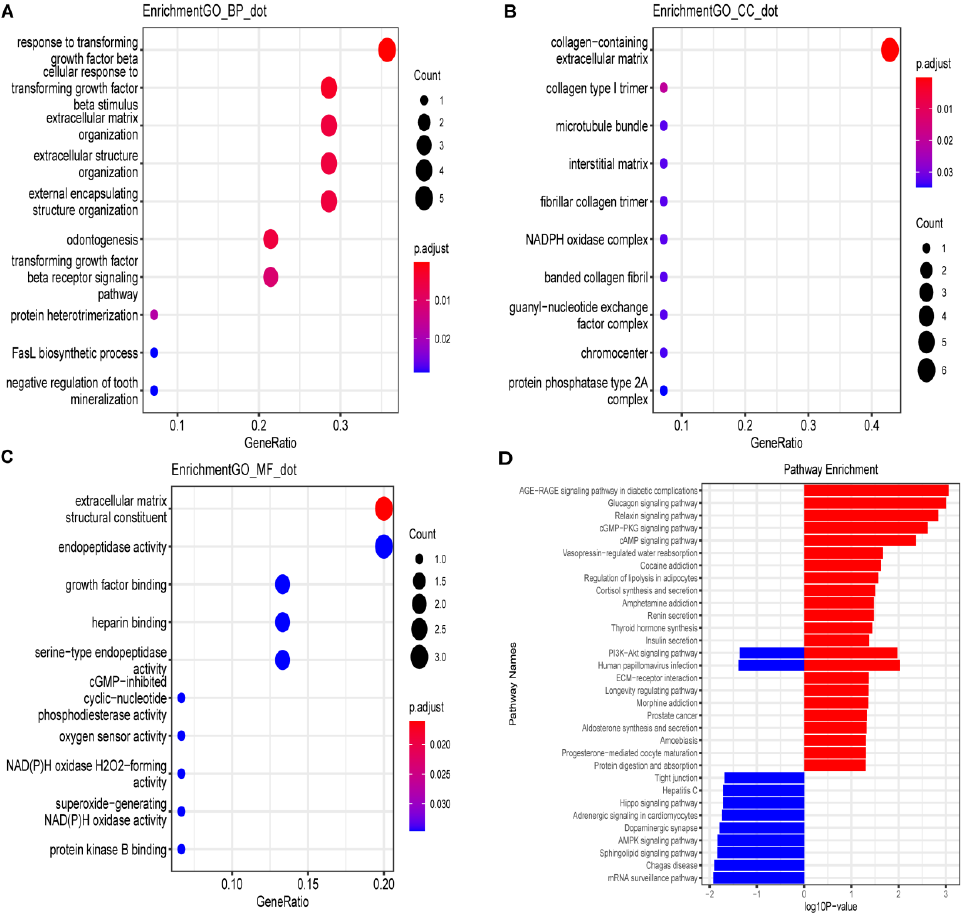
Figure 2. Gene ontology (GO) and Kyoto Encyclopedia of Genes and Genomes (KEGG) pathway enrichment analyses of the 15 common genes. Dot sizes represent counts of enriched genes, and dot colors represent the adjusted p value. P.adj < 0.05. ( A ) GO terms involved by common genes in biological process (BP) category. ( B ) GO terms in cellular component (CC) category. ( C ) GO terms in molecular function (MF) category. ( D ) KEGG pathway enrichment analysis of 15 common genes.